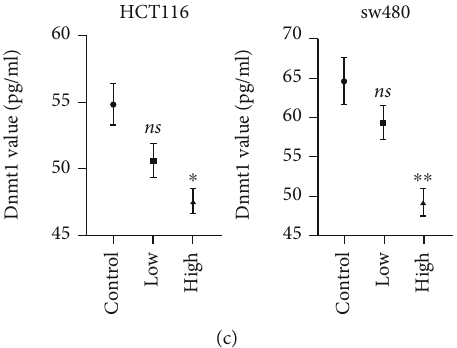
Figure 5: Feno fi brate decreased the content of DNMT1 and increased the expression of tumor suppressor genes. (a) qRT-PCR analysis of DNMT1 and PPARA mRNA expression in HCT116 and SW480 cells following feno fi brate treatment. Data was presented as mean ± SD ( ∗ P < 0 : 05 , ∗∗ P < 0 : 01 , ∗∗∗ P < 0 : 001 ). (b) The mRNA expression of p21, p27, CDKN2A, MLH1, RASSF1A, APC, GSTP1, H4F2, ACOX1, Oct4, Nanog, and Sox9 was measured. Data was presented as mean ± SD ( ∗ P < 0 : 05 , ∗∗ P < 0 : 01 , ∗∗∗ P < 0 : 001 ). (c) DMNT1 value was measured using ELISA kit. Data was presented as mean ± SD ( ∗ P < 0 : 05 , ∗∗ P < 0 : 01 , ∗∗∗ P < 0 : 001